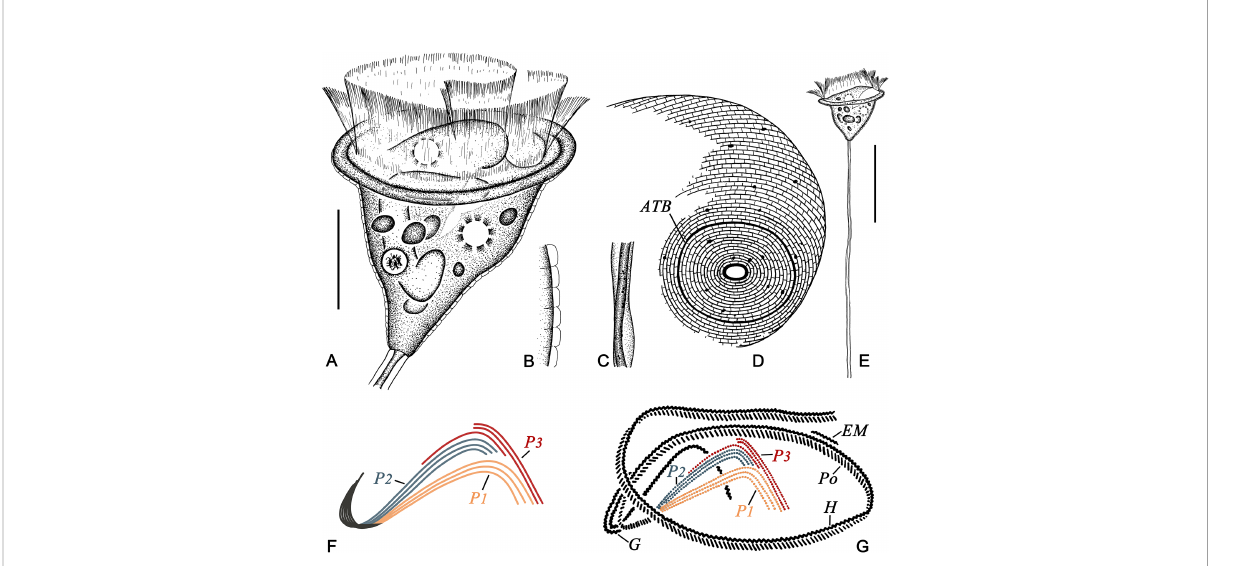
FIGURE 1 Pseudovorticella zhejiangensis sp. n. from life (A – C, E) , after silver nitrate staining (D) , and after protargol staining (F, G) . (A) Typical shape of the zooid. (B) Pellicular blisters. (C) Details of the stalk and spasmoneme. (D) Silverline system, showing the posterior part of the zooid. (E) An individual with stalk and zooid. (F) Arrangement pattern of the three infundibular polykineties. (G) Oral ciliature. ATB, aboral trochal band; EM, epistomial membrane; G, germinal kinety; H, haplokinety; Po, polykinety; P1 – 3, infundibular polykinety 1 – 3. Scale bars: 30 m m (A) and 60 m m (E) .